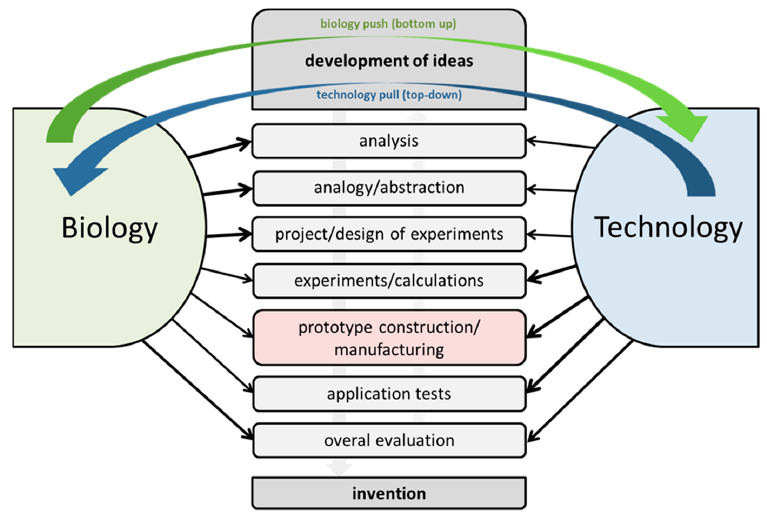
Figure 1. Simplified flow chart of a biomimetic development process, according to [7] (Copyright: Fraunhofer UMSICHT/BIOKON).